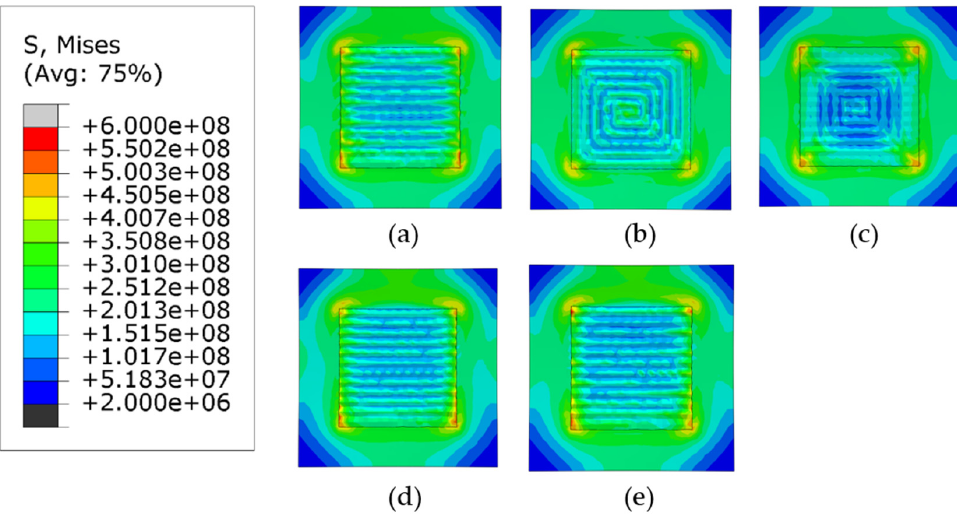
Figure 9. Mises stress distribution of different deposition patterns at the end of the simulation, when phase transformations are not considered, (top view, unit: Pa); ( a ) alternate, ( b ) in–out, ( c ) out–in, ( d ) raster, ( e ) zigzag.